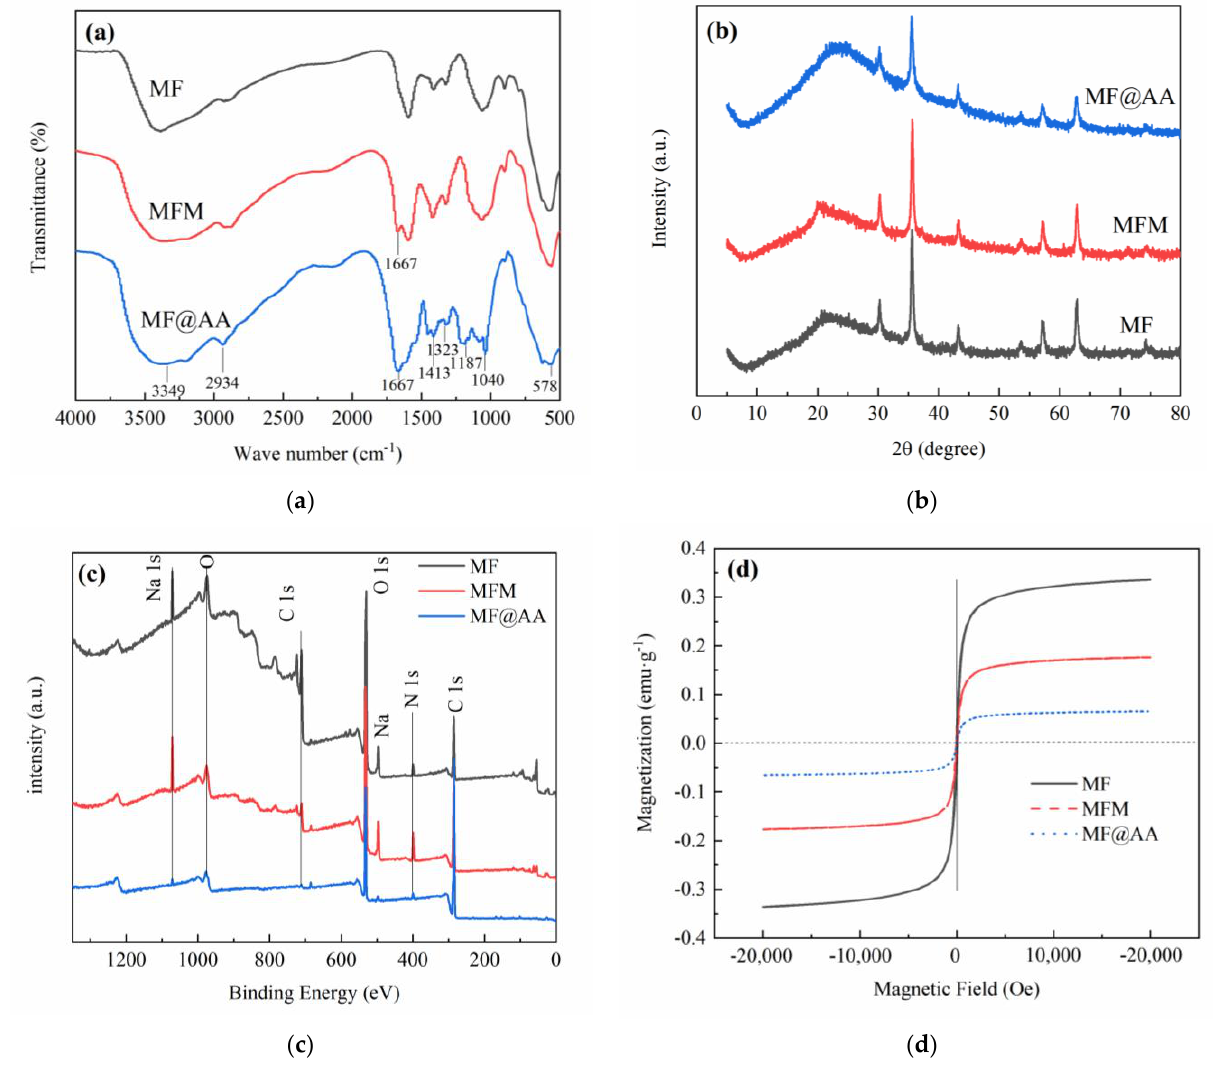
Figure 2. Characterization of magnetic flocculants: ( a ) FTIR spectrum, ( b ) XRD spectrum, ( c ) XPS images, and ( d ) VSM curve of magnetic flocculants.